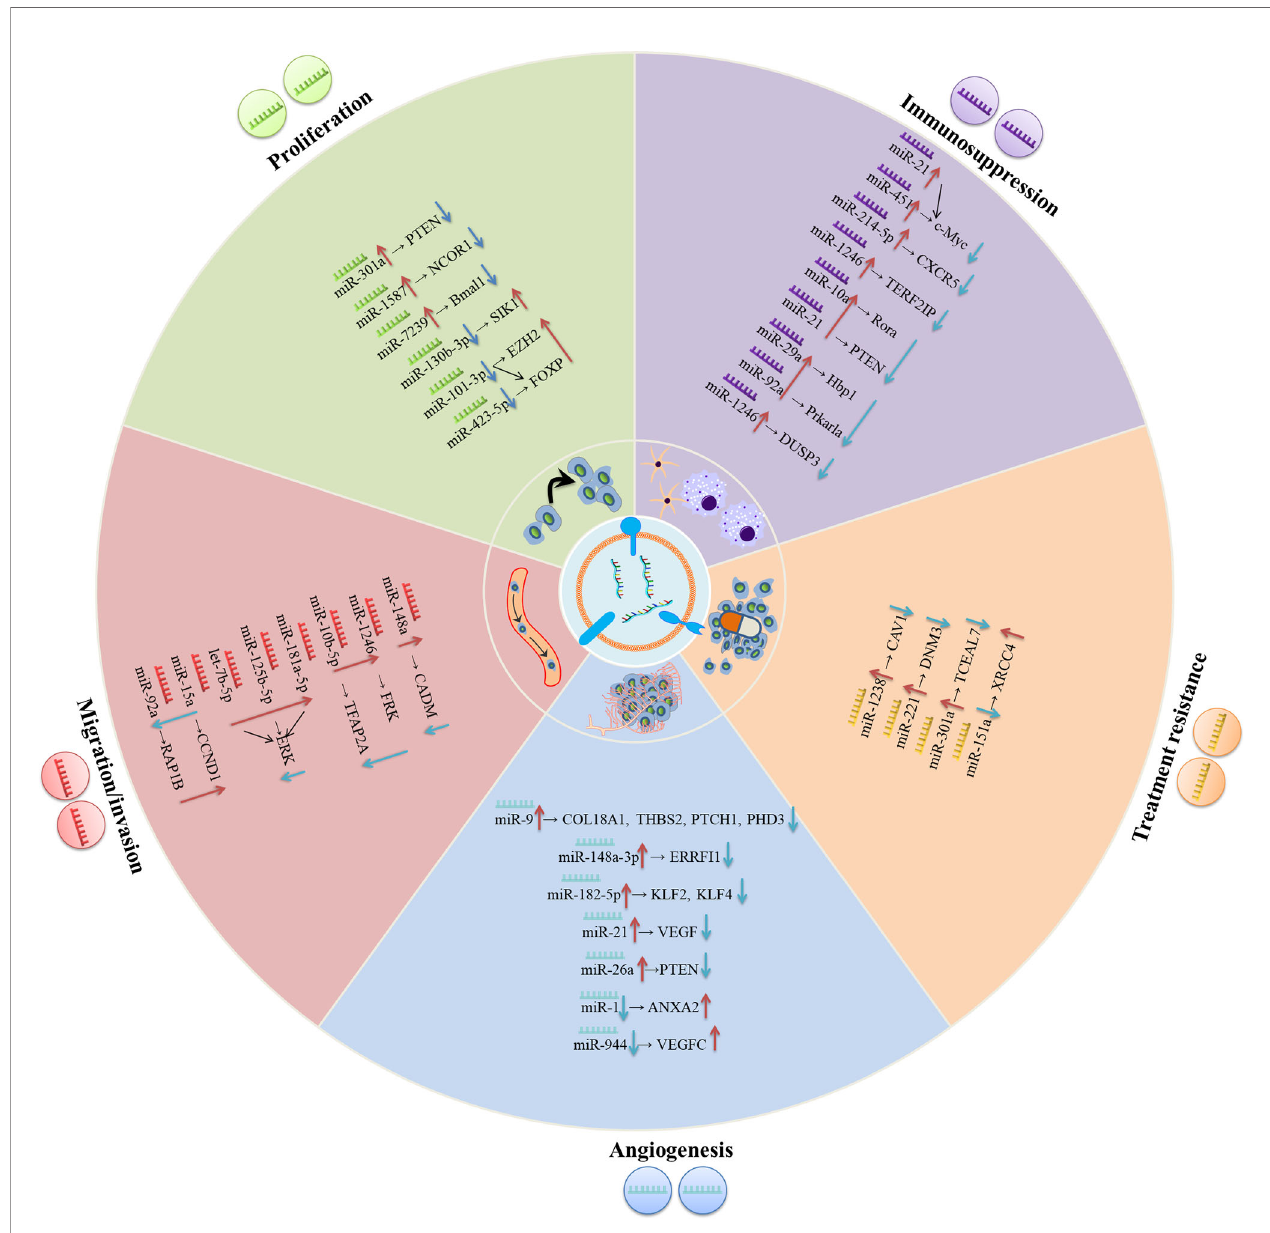
FIGURE 1 | The underlying molecular mechanisms of exosomal miRNAs in modulating the progression of gliomas. In the glioma environment, exosomal miRNAs are absorbed by recipient cells and subsequently exert their functions in varieties of biological processes including proliferation, migration/invasion, angiogenesis, treatment resistance, immunosuppression,